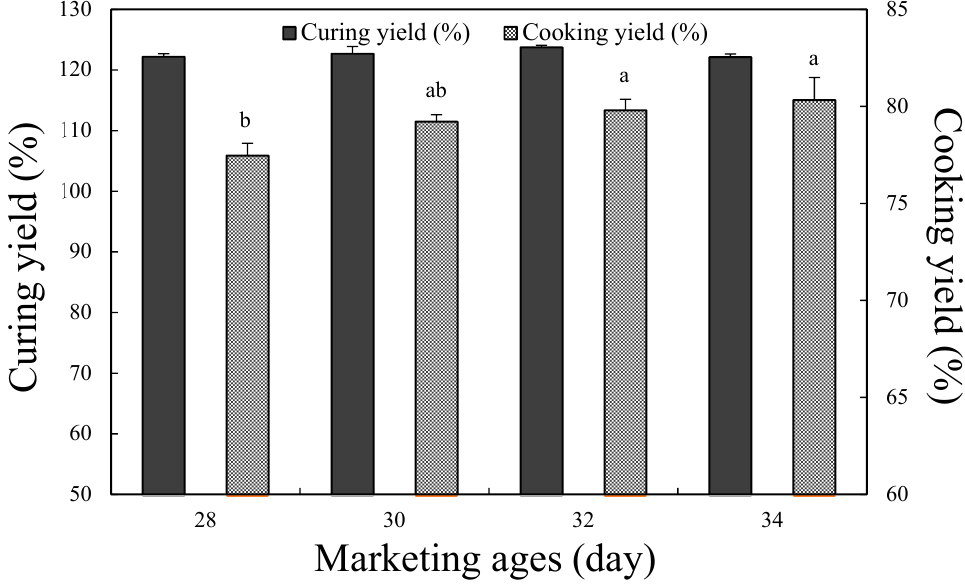
Figure 1. Curing yield and cooking yield of cured chicken breast with various marketing ages. a–b Means on the same bar with different letters are significantly different ( p < 0.05).